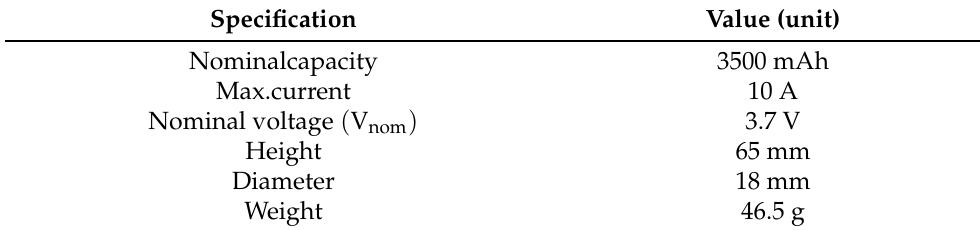
Figure 13. Nyquist plot for a real battery. The Nyquist plot in red depicts the impedance response of the battery with 0.2 A DC current. The impedance response of the battery with 0 DC current is shown in blue. Table 1. Battery specifications.